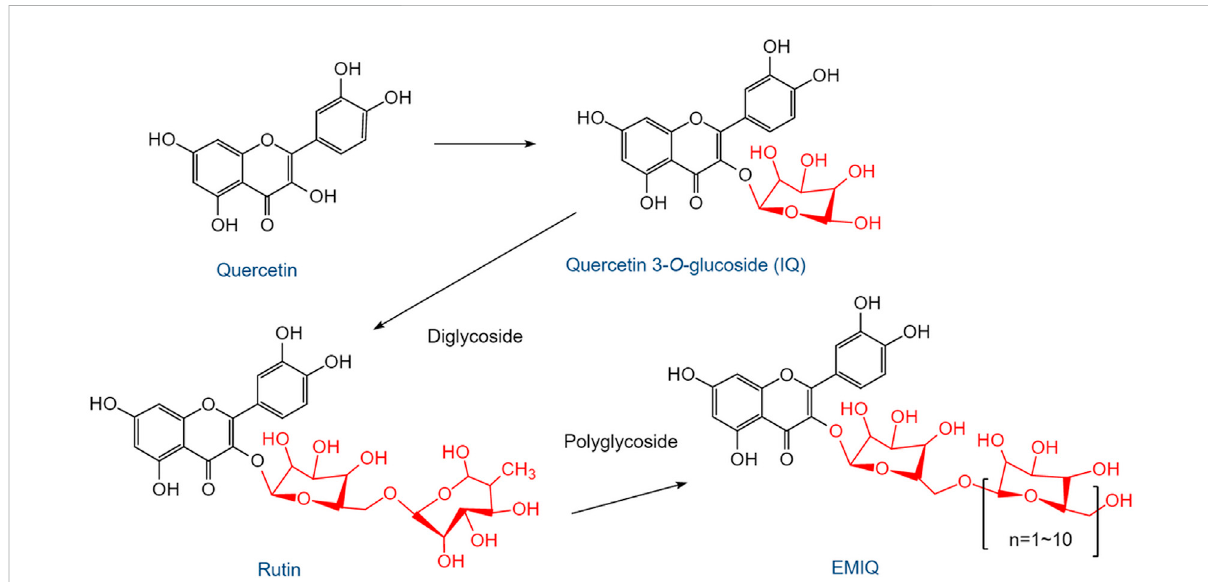
FIGURE 2 ThestructuresandtransformationprocessofQURanditsimportantglycosidemetabolites.AfteringestingQURfromplants,mammalsabsorbit undertheactionofmicroorganisms inthegut. QURundergoesaglycosylation processto formQUR3- O glycosides,themostimportant ofwhich is IQ.IQcancontinuetocombinewithglycosidestoformthediglycosideQUR,alsoknownasrutin.RutincanalsoformIQbydeglycosidation.Ifrutinis further bound to several glycosides, EMIQ will be formed. IQ, isoquercetin; EMIQ, enzymatically modi fi ed